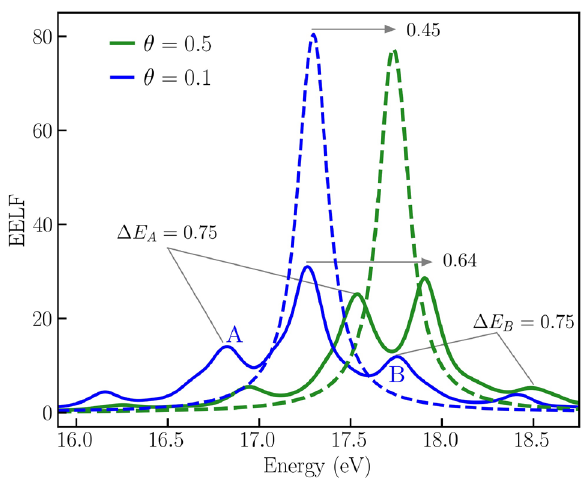
Figure 1. A novel mode of electronic excitation (solid blue and green curves) that emerges in inhomogeneous WDM. The new mode is observed in the EELF along the wave vector. Q when a perturbation amplitude U 0 = 0.1 is imposed on the electronic structure. The EELF is shown for q = 0.431 Å − 1 at temperatures θ = 0.5 (solid blue) and θ = 0.1 (solid green). The new mode differs significantly from the well-explored plasmon mode (dashed blue and green curves). It also has a pronounced temperature